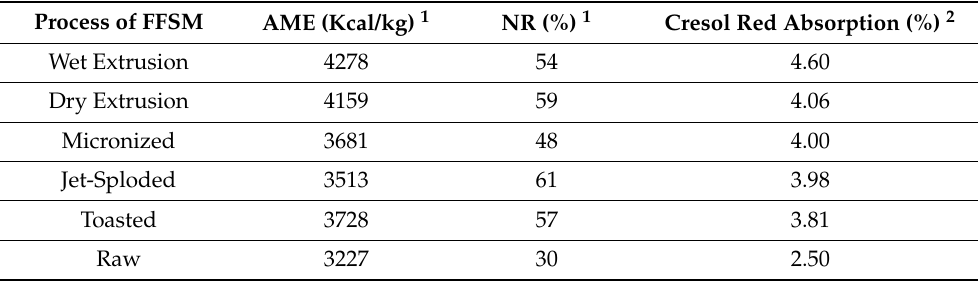
Table 7. Poultry Apparent Metabolizable Energy (AME), Nitrogen Retention (NR), and Cresol red absorption of Processed FFSBM